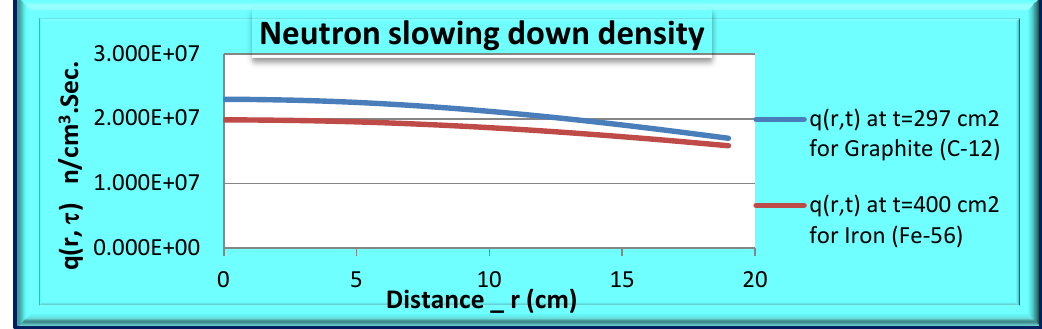
Fig.5: Neutron slows down density for various materials Using Indium foil